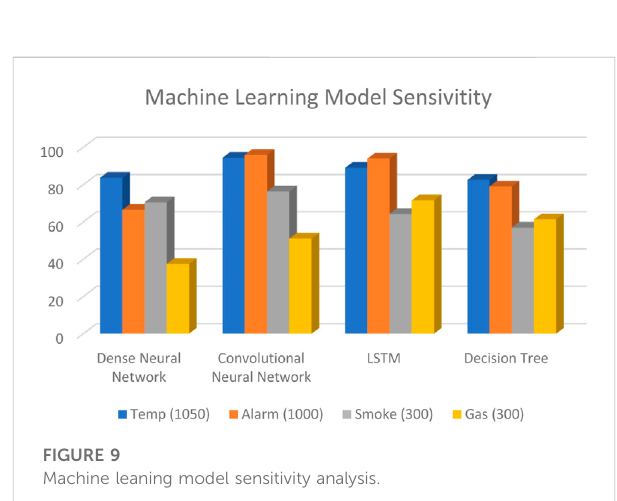
FIGURE 9 Machine leaning model sensitivity